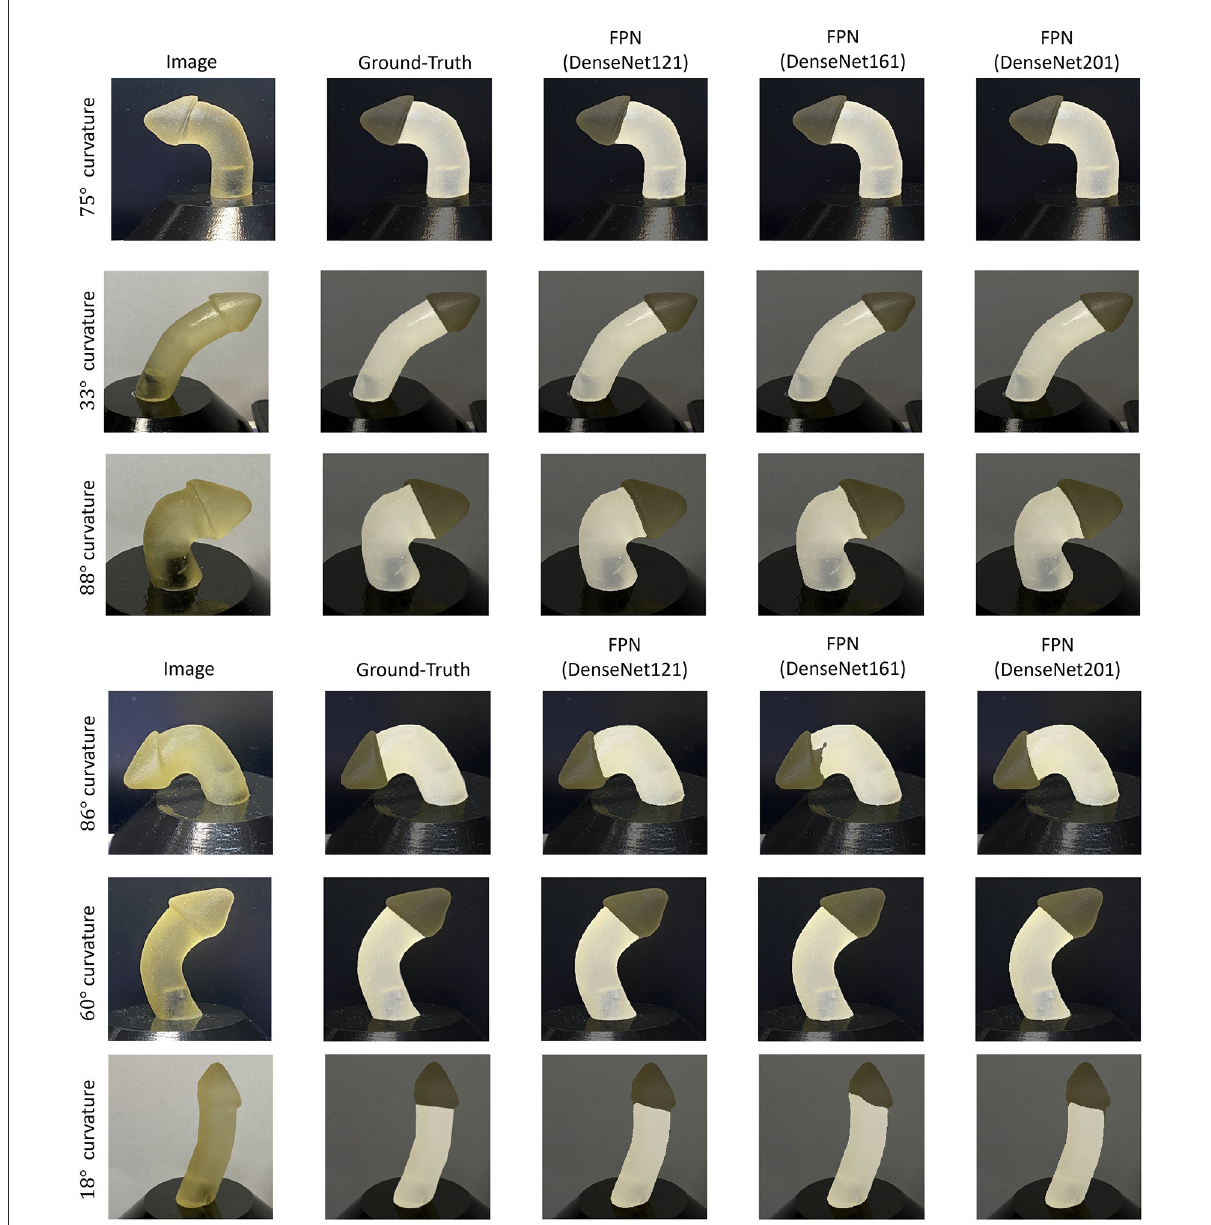
FIGURE5 Sample qualitative evaluation of the top-three performing shaft segmentation